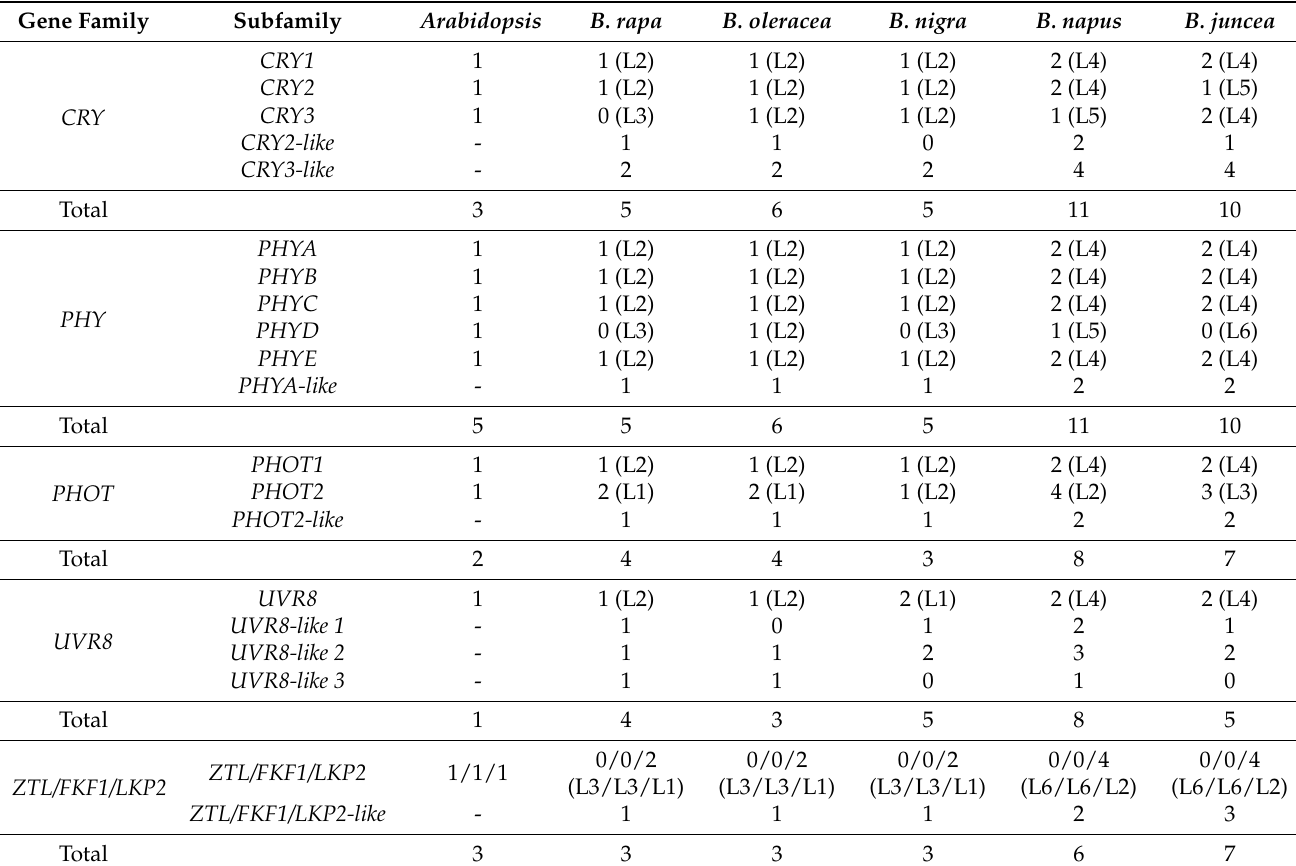
Table 1. Expansion and contraction of photoreceptor gene families in Brassica